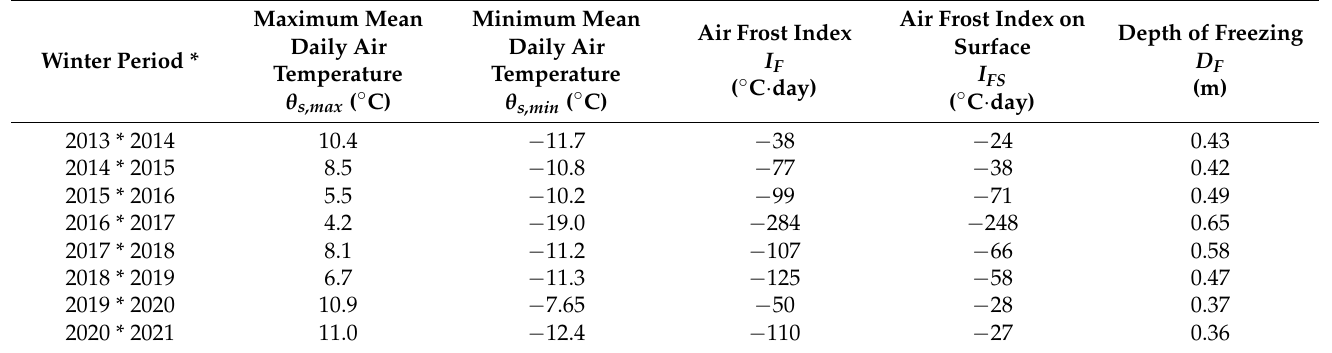
Table 3. Climatic characteristics achieved from measurements at the experimental stand No. 2